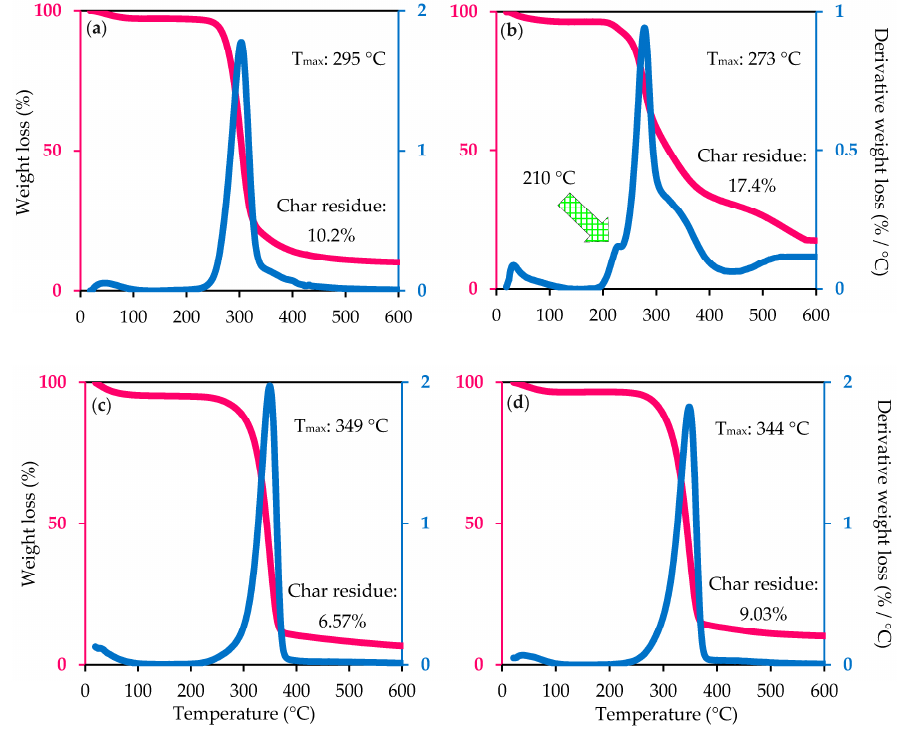
Figure 6. Thermogravimetric (TG) and its derivative curves (DTG) of the: ( a ) Native cellulose; ( b ) Sulfated CNC H2SO4 ; ( c ) Neutralized CNC H2SO4 ; and ( d ) CNC Cr(NO3)3 . Table 2. Thermal profile of cellulosic material and its nanostructured product derived from various raw materials via different hydrolysis method in previously published studies.